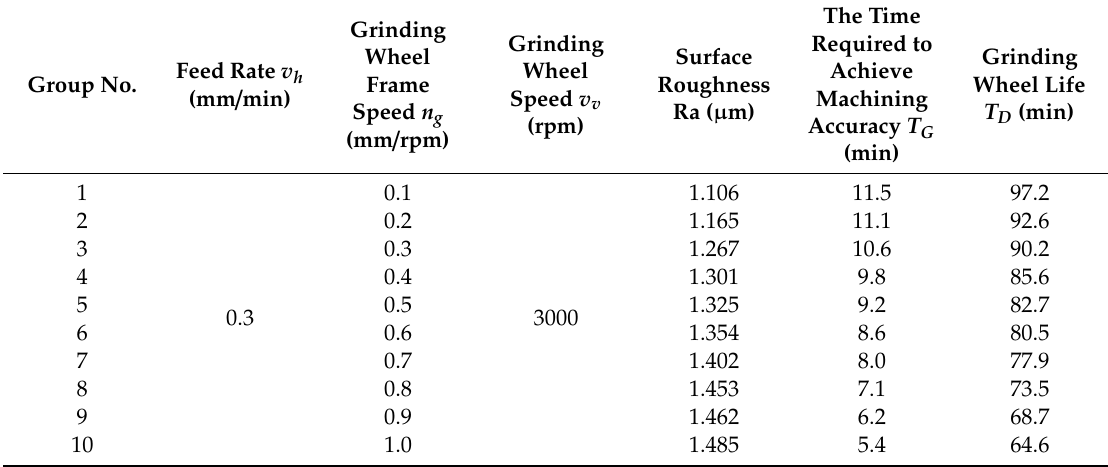
Table 8. The experiment grouping and results of exploring the impact of the grinding wheel frame speed.